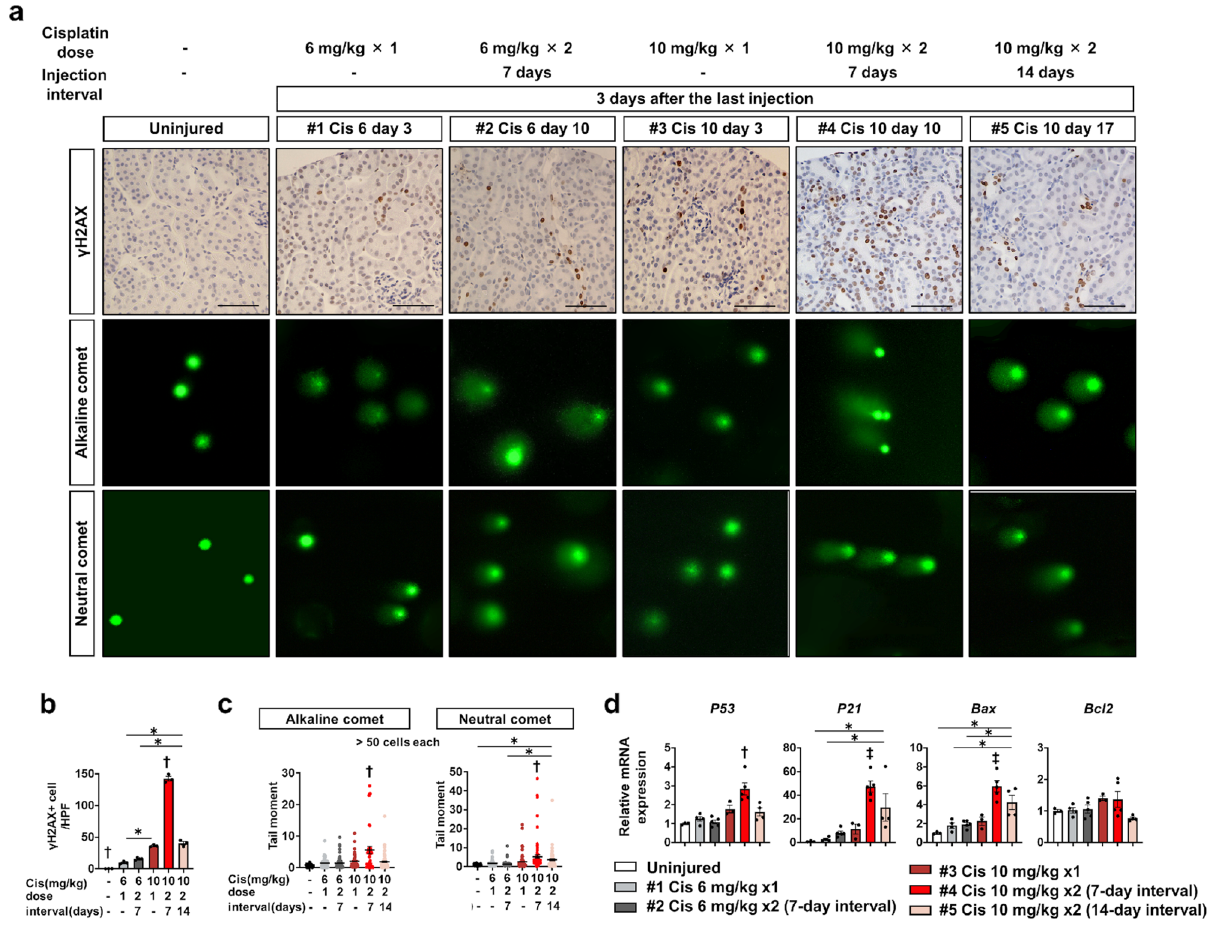
Figure 4. Assessment of DNA damage after different frequencies, doses, and intervals of cisplatin injection. ( a ) Representative images of immunostaining of γH2AX and comet assay of isolated kidney cells at three days after the last injection. ( b ) Quantification of the number of γH2AX + cells. ( c ) Quantitative analysis of alkaline comet and neutral comet. ( d ) Quantitative PCR of whole kidneys for the downstream target genes of DNA damage ( p53, p21 , Bax, and Bcl2 ). Data are the mean ± SE. * P < 0.05, † P < 0.05 vs other groups, ‡ P < 0.05 vs Uninjured or #1–3 groups. Scale bar = 100